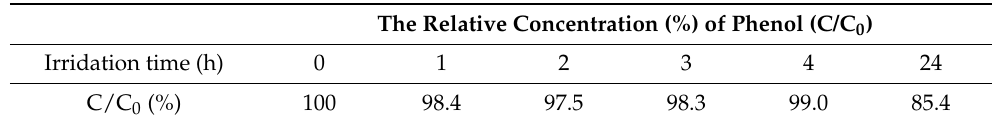
Table 2. The dependence of the relative concentration (%) of phenol (C/C 0 ) in an aqueous solution on the ultraviolet irradiation time (hour) in the absence of ZnO particles in the solution. The Relative Concentration ( % ) of Phenol ( C/C 0 ) Irridation time (h) 0 1 2 3 4 24 C/C 0 (%) 100 85.4